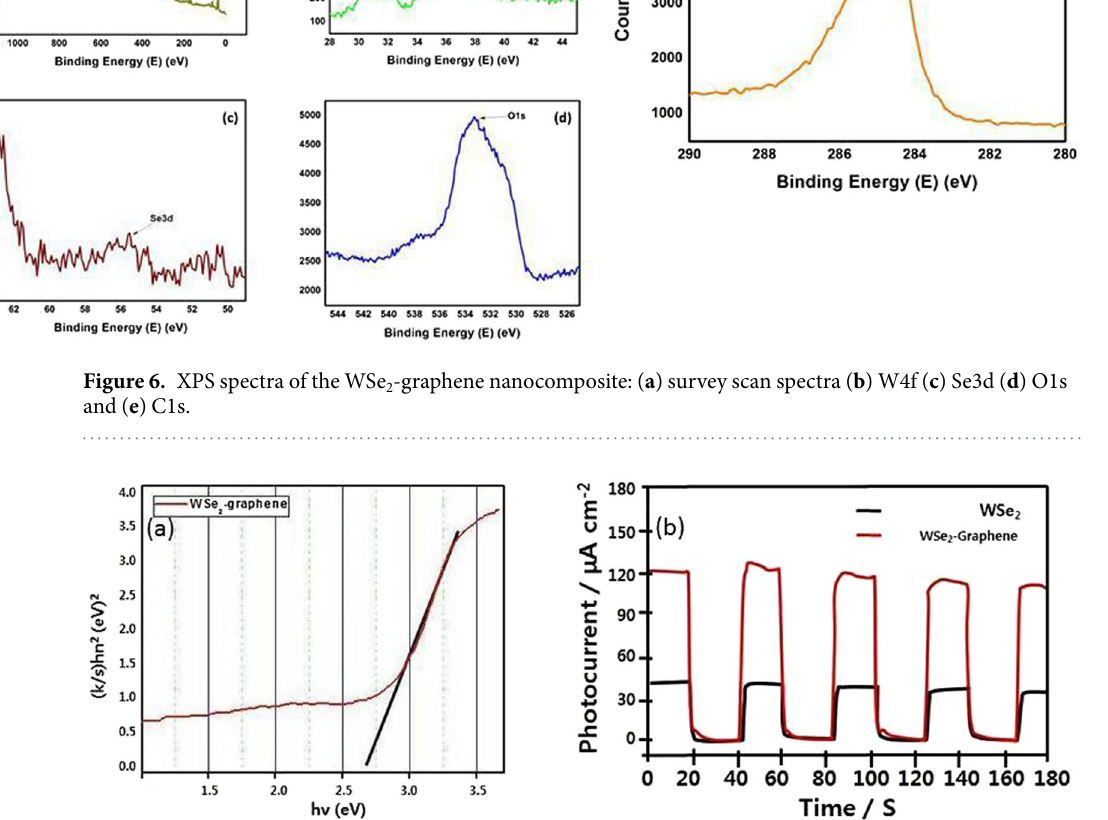
Figure 7. DRS of the WSe 2 -graphene composite and photocurrent measurement with pure WSe 2 semiconductor ( a ) and WSe 2 -graphene modified photoelectrodes ( b